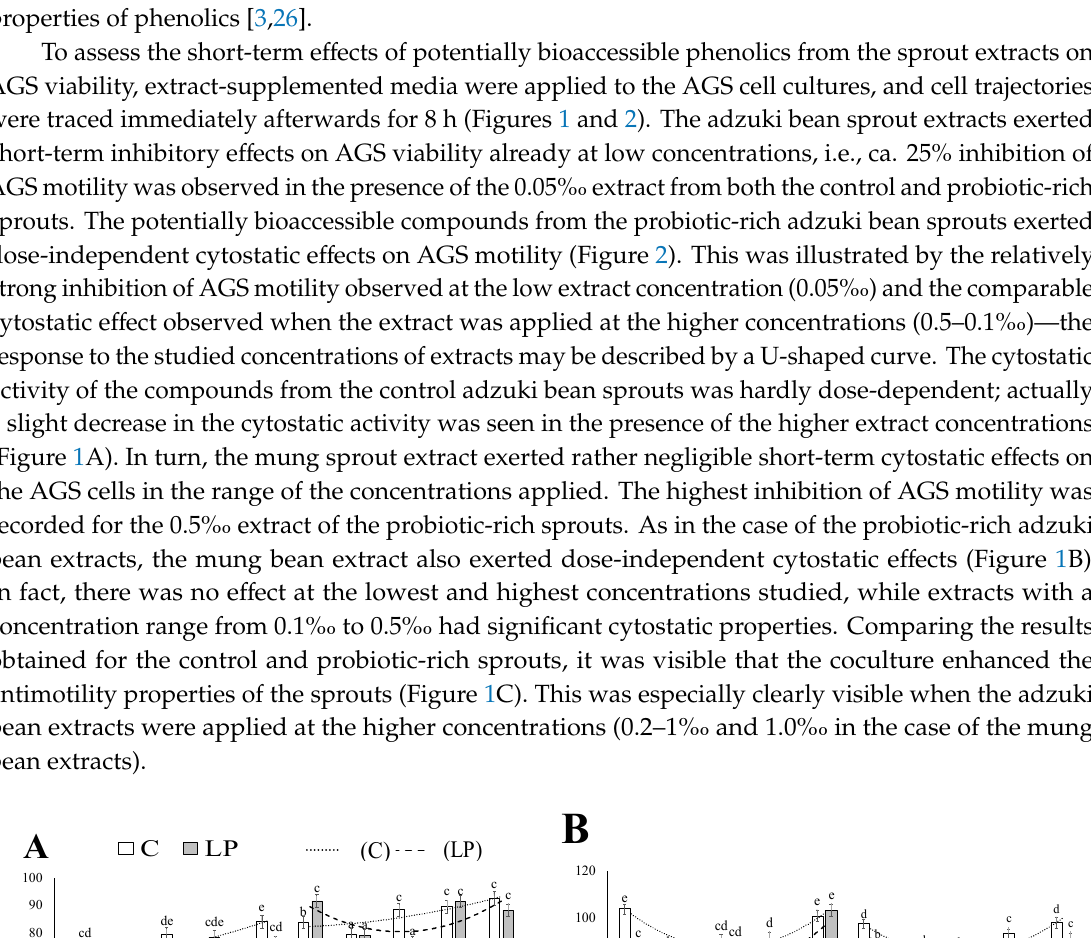
Figure 1. Effects of the digest on the speed and migration of human gastric cancer (AGS) cells. ( A )Adzuki bean (AB), ( B )mung bean (MB), and ( C ) comparison control vs. probiotic-rich sprouts. Bar graphs depict averaged AGS motility and displacements estimated from the trajectories of at least 50 cells (control = 100%). Means (±SD) for the selected activity followed by different letters are significantly different ( n = 9; p ≤ 0.05). C—control sprouts and LP—sprouts enriched with Lactobacillus plantarum.